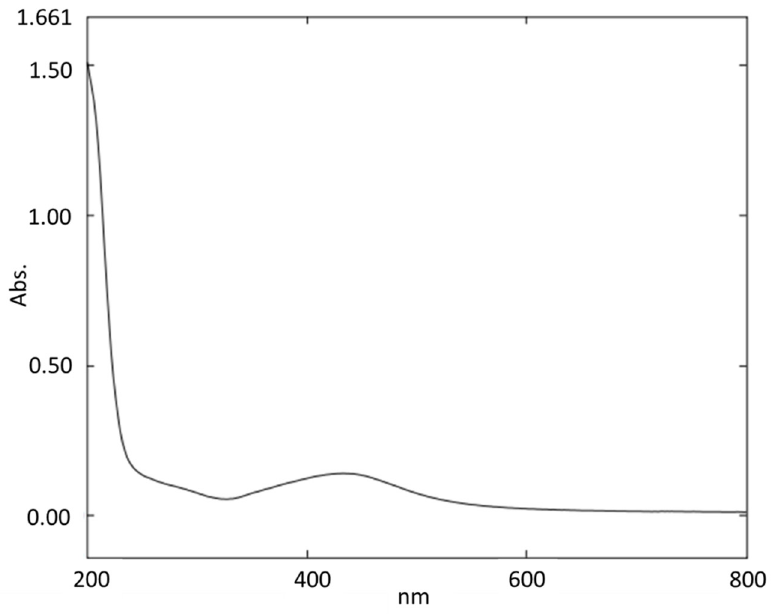
Figure 1. UV–Vis spectroscopy for the synthesized silver nanoparticles.